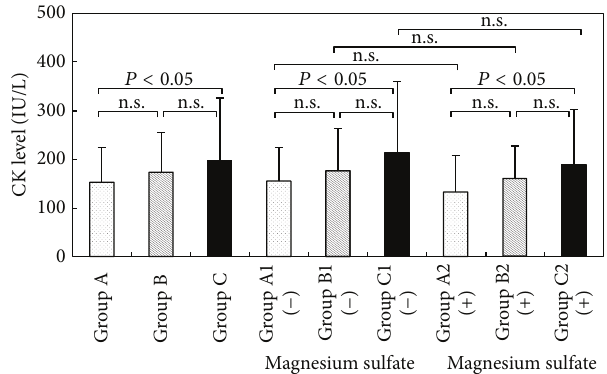
Figure 1: CK levels in umbilical blood after tocolysis. ∗ 𝑃 < 0.05 (compared with control group).